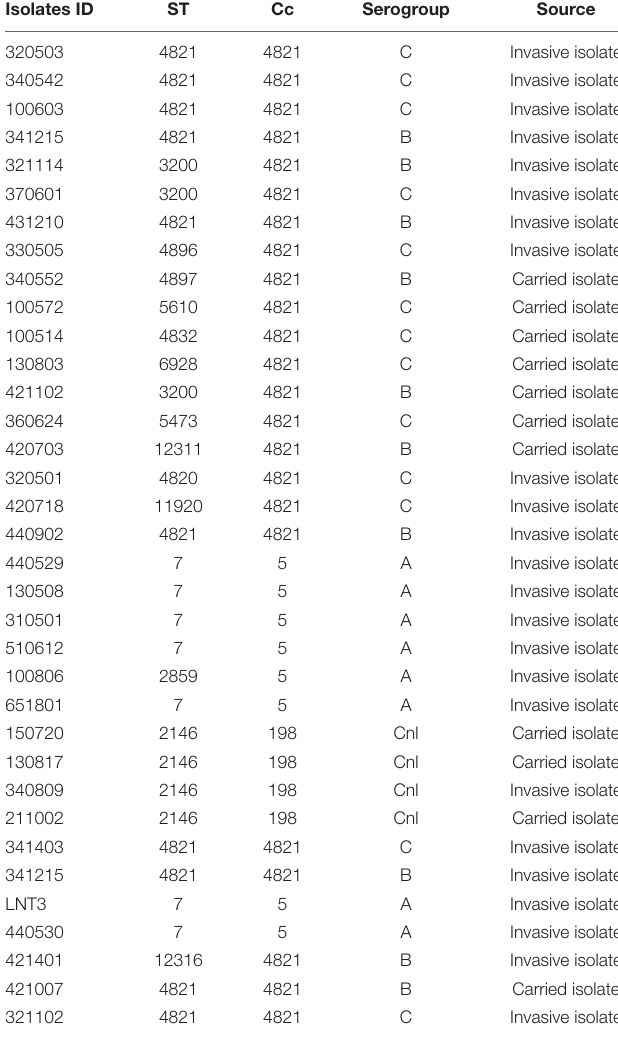
TABLE 1 | | Neisseria meningitidis isolates used in this study. Isolates